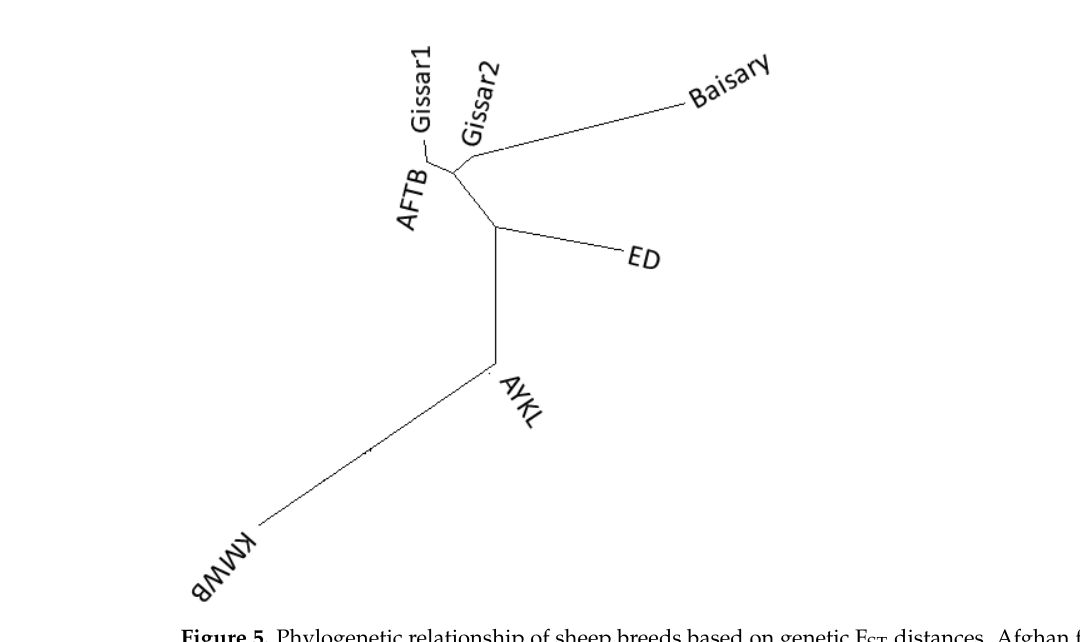
Figure 5. Phylogenetic relationship of sheep breeds based on genetic F ST distances. Afghan fat-tailed breed (AFTB), Aykol (AYKL), Edilbay (ED), Gissar2 (imported from Kyrgyzstan), Baisary (BAI), Kazakh meat-wool breed (KMWB), Gissar1 (imported from Tajikistan).